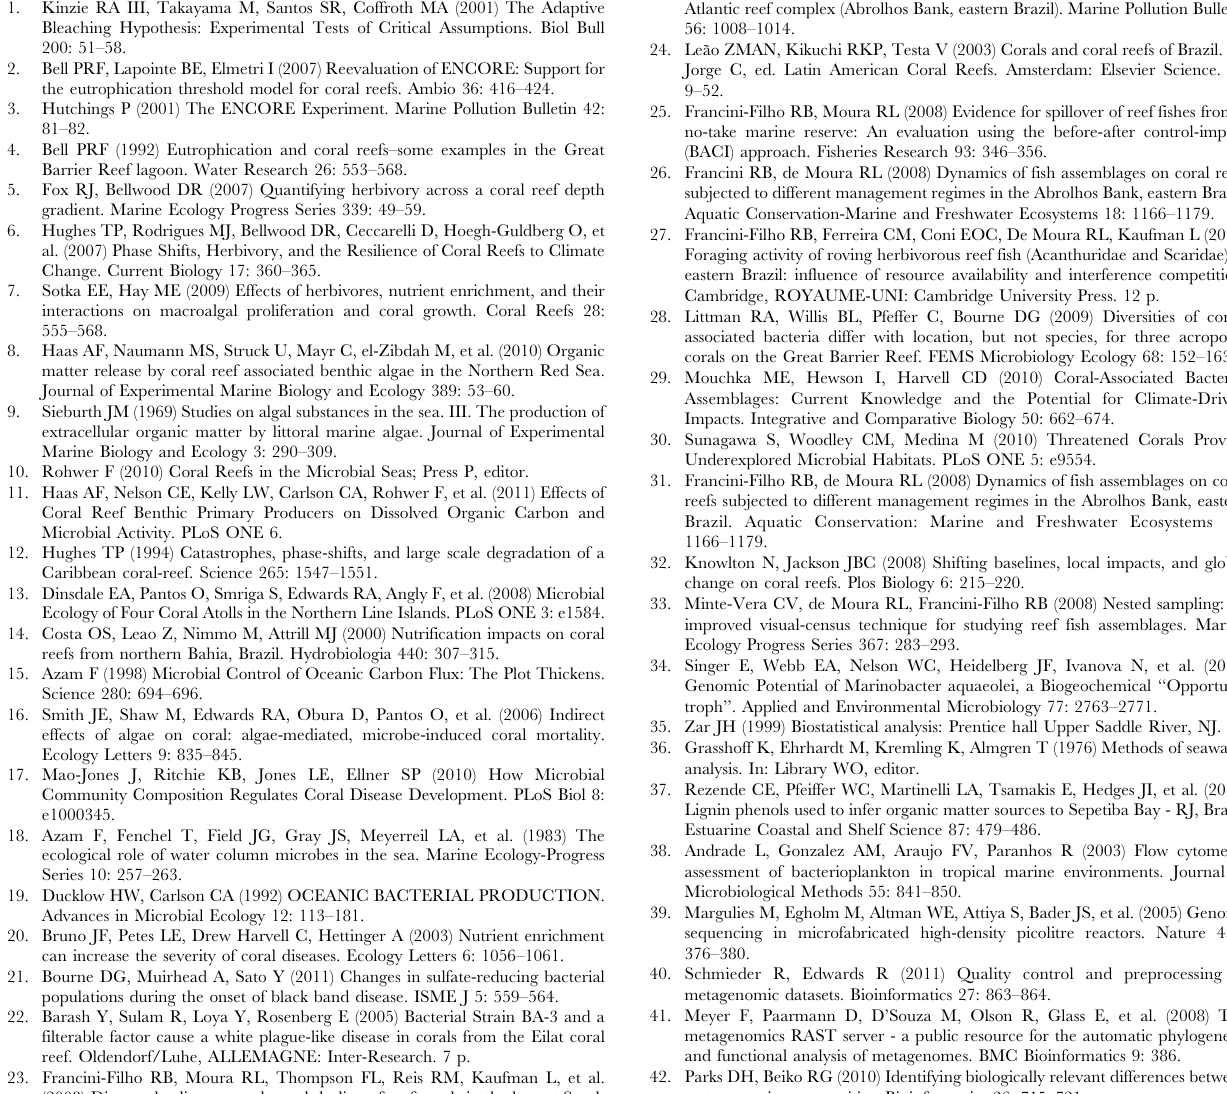
lisms). The top ten subsystems in hierarchy 3 were listed to the subsystems hierarchy 1. The numbers between brackets represent the number of subsystems at hierarchy level 1 of identification in the unprotected and unprotected